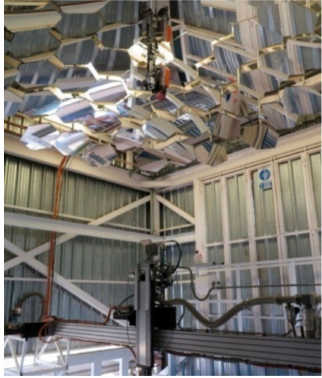
Figure 1. SF5 vertical axis solar furnace (test